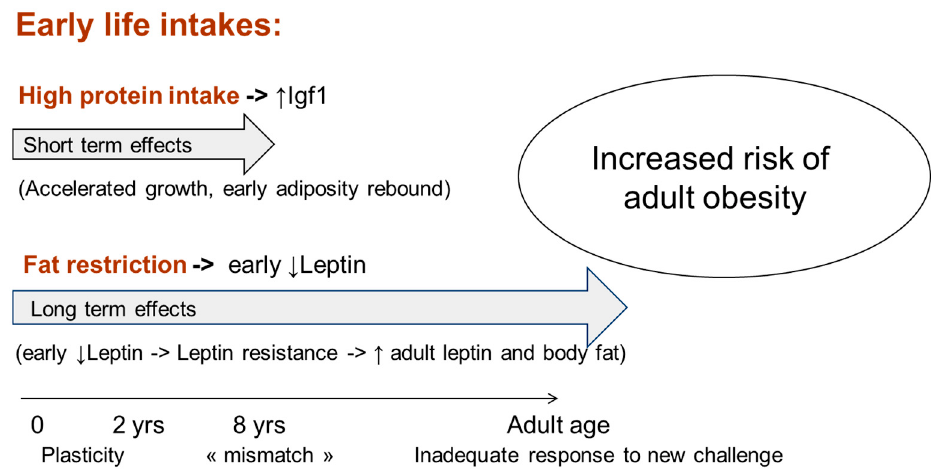
Figure 4. Short and long term effects of imbalance diet in early life.